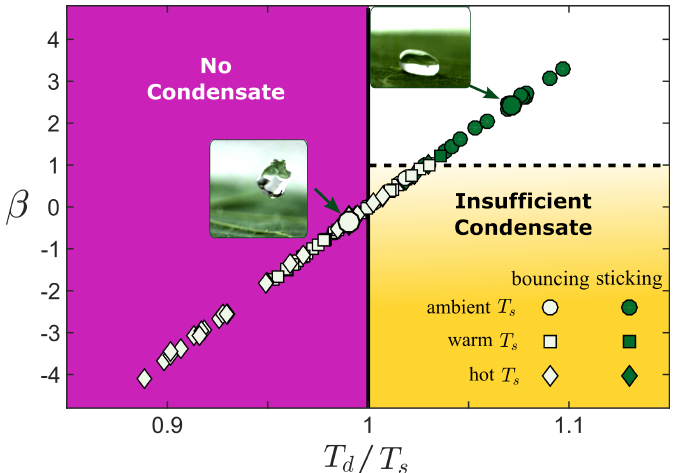
Figure 7. A phase plot illustrating the three condensate regimes. The experimental data from Figure 5 is replotted in terms of the temperature ratio T d / T s and the proposed dimensionless group β (Equation (3)). Here, only data below the melting temperature T m is considered. When no condensate is expected to form within the microtexture (purple region), the drop is expected to bounce, whereas, when significant condensation is expected within the microtexture, it is expected to stick (white region). The finite timescale of the bounce introduces a third regime (yellow region) in which condensate develops but can be insufficient to trap the